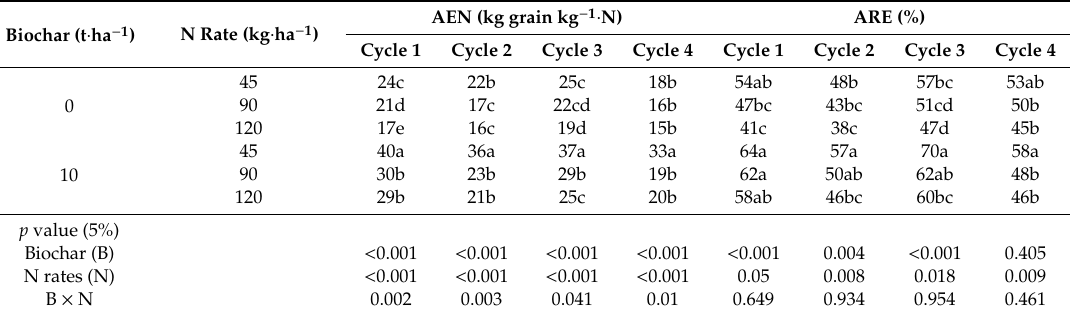
Table 7. E ff ect of biochar amendment and Nitrogen fertilization on agronomic e ffi ciency